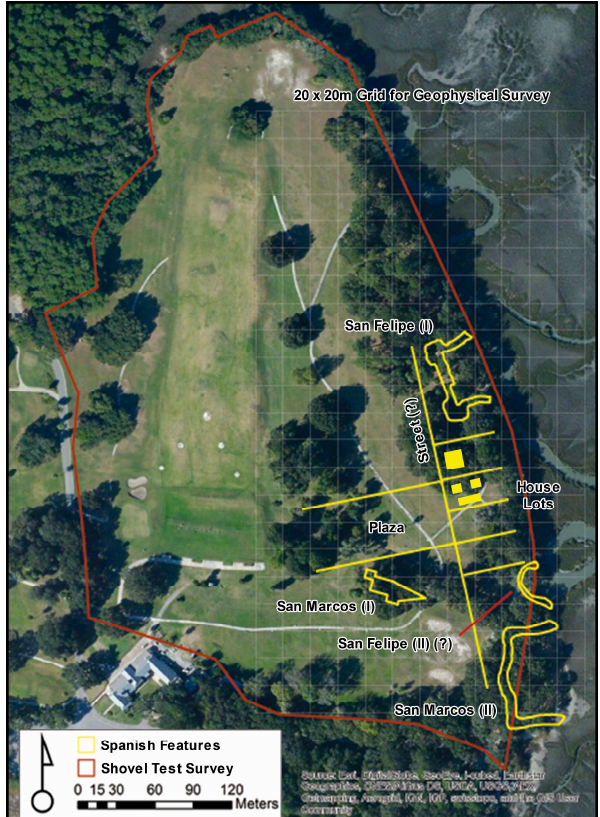
Figure 3. Aerial view of the Santa Elena site overlain with the 20 m × 20 m grid used to conduct the geophysical surveys. Interpretations of Spanish settlement features are adapted from DePratter and South (1995:83–87).